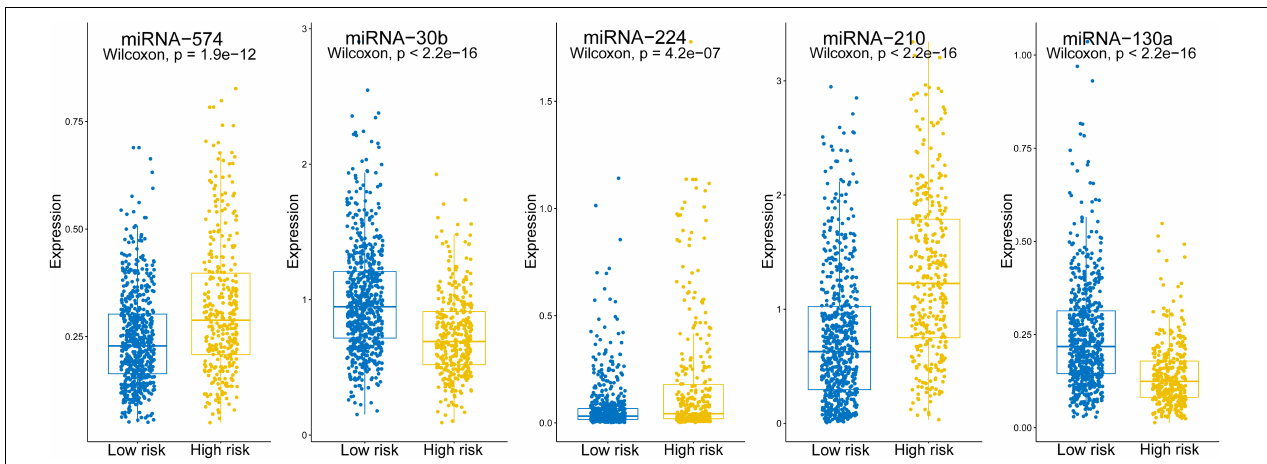
Frontiers in Cell and Developmental Biology |